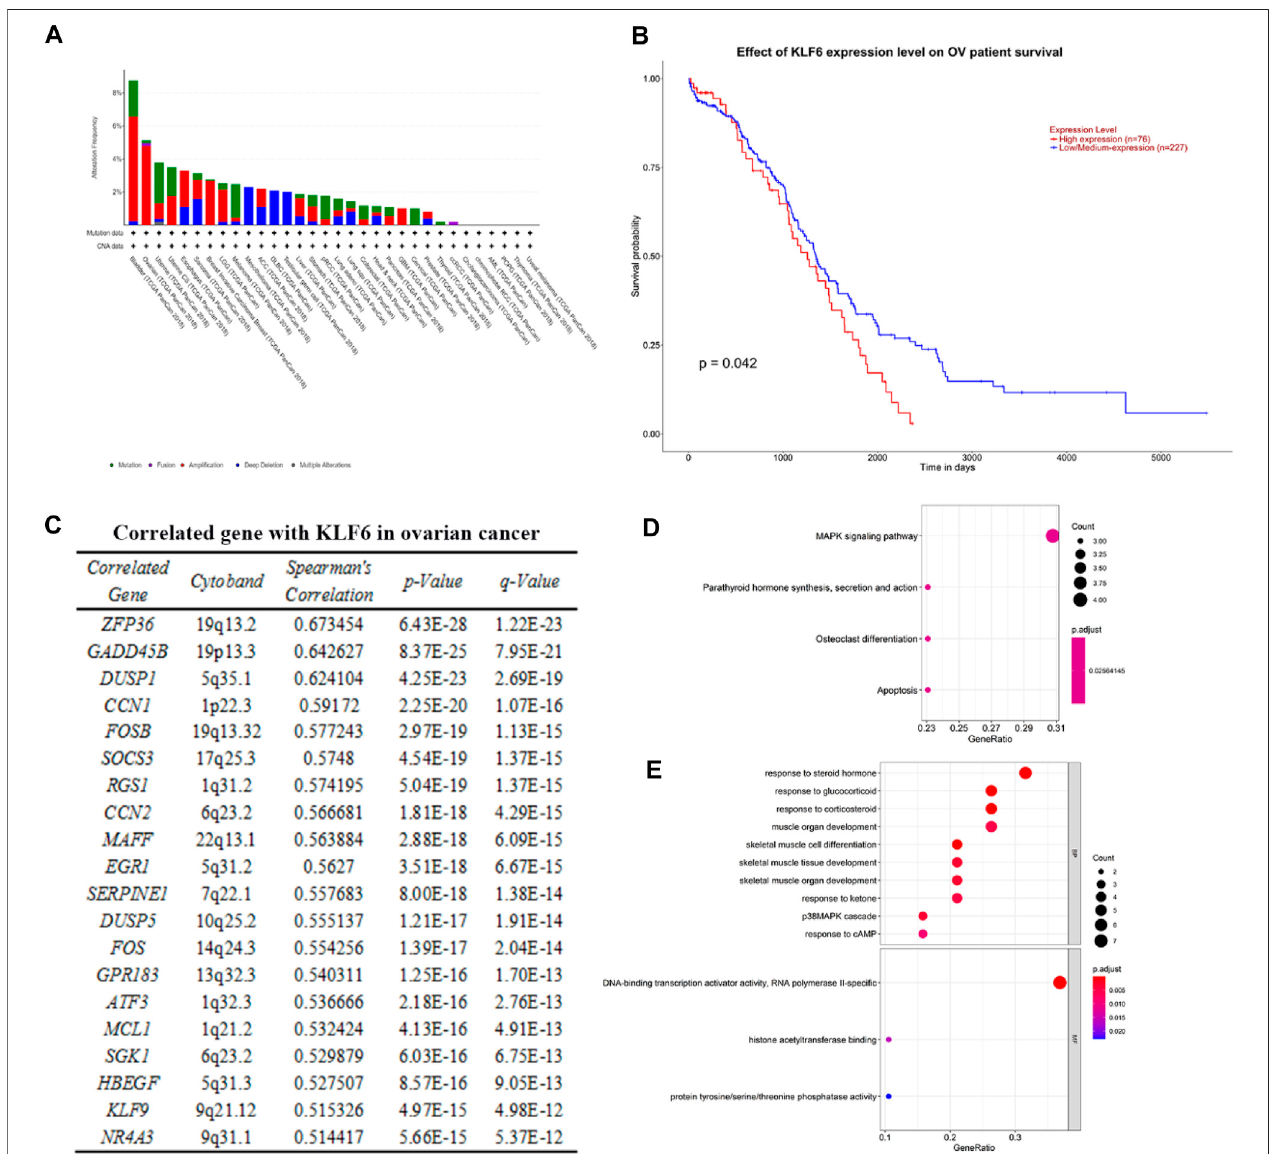
FIGURE 1 | Correlation between KLF6 and ovarian cancer and pathway enrichment analysis. (A) Using the TCGA PanCancer Atlas database of cBioPortal, the alterationfrequencyofKFL6invariouscancerwasobtained. (B) EffectoftheKLF6expressionlevelofovariancancerpatientsurvivalbasedontheTCGAOVdatabaseof UALCAN. (C) Co-expressed genes with KLF6 in ovarian cancer samples according to the mRNA expression pro fi les of the TCGA database. (D, E) KEGG and GO analysis of modular genes by the R package of clusterPro fi ler. The enrichment fi le is in KEEG. and GO. txt.